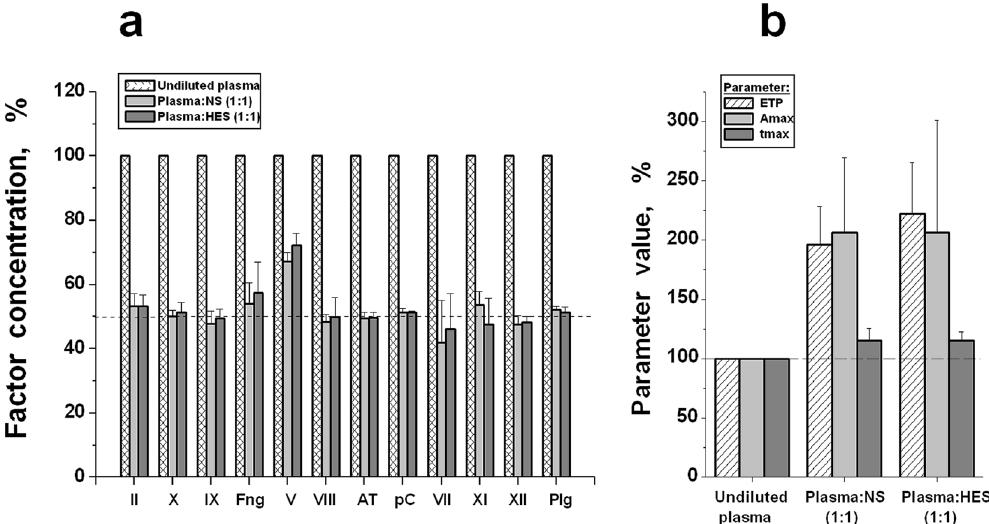
Figure 4. The decrease in concentration of coagulation factors and inhibitors during plasma dilution and its connection with coagulation efficiency. The results are presented in % relative to the corresponding value in undiluted plasma. ( a ) - Concentrations of the factors: II, X, IX, fibrinogen (Fng), V, VIII, VII, XI, XII; inhibitors: antithrombin III (AT) and protein C (pC); and plasminogen (Plg) in undiluted plasma, and plasma diluted two- fold with NS or HES. ( b ) - Parameters of TGT in these plasma samples: ETP (endogenous thrombin potential), A max (maximal concentration of thrombin in the sample), and t max (time to maximal thrombin concentration). The averaged values are presented as the mean values ± SD (n = 3).